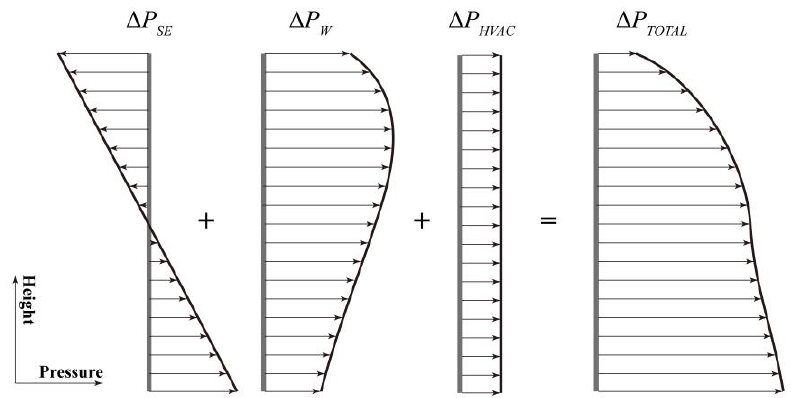
Figure 1. Indoor and outdoor absolute pressure profiles by stack effect.